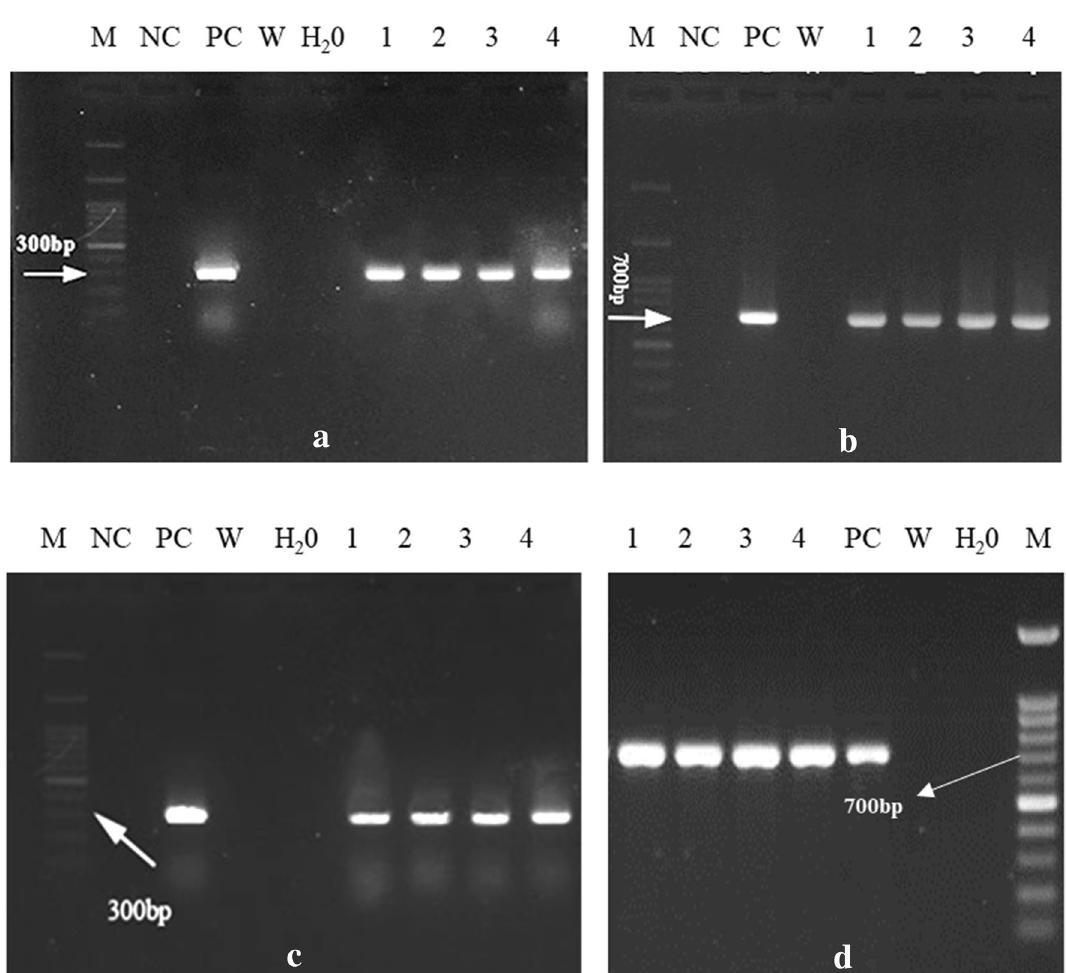
Figure 9. Gel electrophoresis of PCR on genomic DNA from the putative transgenic T 0 plants using the ( a ) GFP and ( b ) GFP-GUS primers; ( c ) gel electrophoresis of PCR on cDNA from the putative transgenic T 0 plants using the GFP primers ( d ) PCR on DNA from four T 1 plants using the GFP-GUS primers. M) DNA Ladder 100 bp; NC) Negative Control; PC) Positive Control containing linear plasmid of binary vector; W) non- transgenic plants; lanes 1, 2, 3 and 4 are transgenic lines screened by GFP